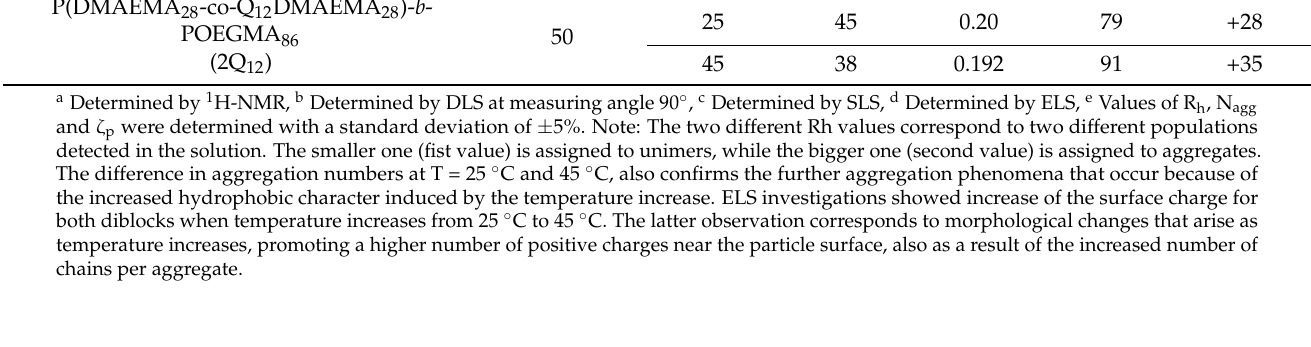
Table 6. Physicochemical characteristics of P(DMAEMA 22 -co-Q 6 DMAEMA 20 )- b -POEGMA 12 and P(DMAEMA 21 -co- Q 12 DMAEMA 21 )- b -POEGMA 12 diblock solutions prepared by the organic solvent protocol (c = 1 × 10 − 3 g/mL), at two different